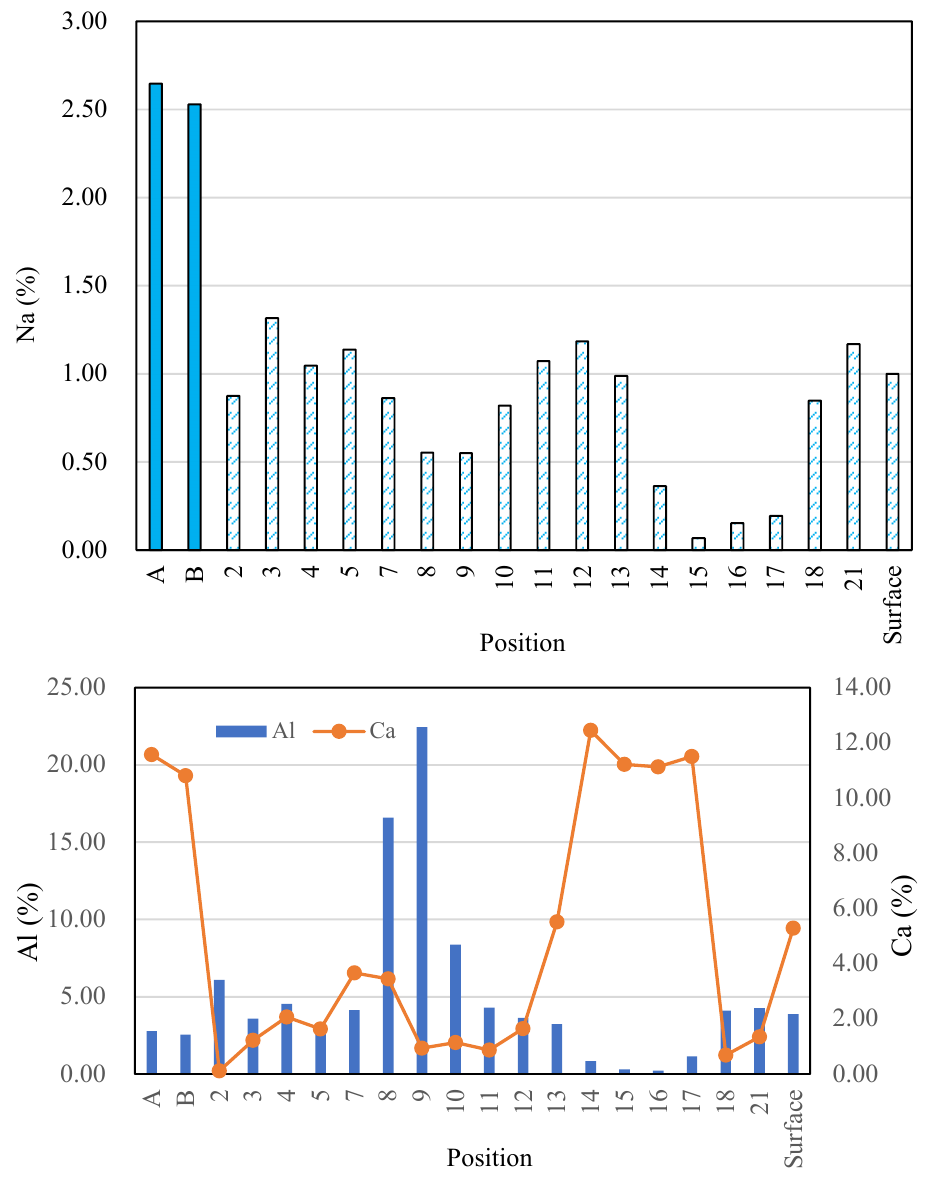
Figure 20. Na, Al, Ca atomic percentages at the outer and inner areas (A, B: average values of each inner area, see Figures 15b and 18; Numbers: analysis results of the points in the outer area; and Surface: average value of the outer area, see Figure 19) .